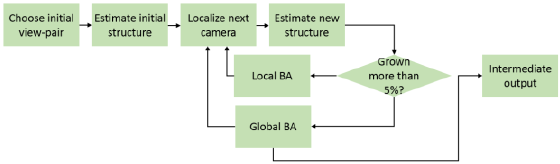
Figure 4: The main steps of the incremental bundle adjustment to derive camera poses and a sparse 3D point